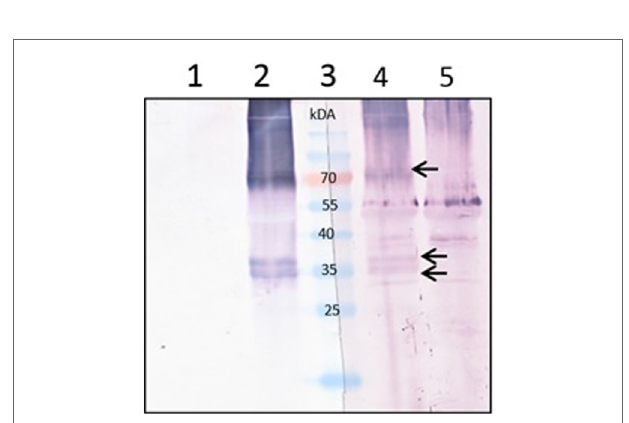
FigUre 3 | Quantification of Zera ® M2e produced in plants . Bovine serum albumin (BSA) was used as a standard. Lane 1 and 7 contained PageRuler ™ Prestained protein ladder (Fermentas), lane 2 contained 6.26 mg/ml, lane 3 contained 3.13 mg/ml, lane 4 contained 1.56 mg/ml, and lane 5 contained partially purified Zera ® M2e plant-codon optimized protein. While lane 6 is a western blot containing the partially purified Zera ® M2e plant-codon optimized protein detected with anti-Zera ® antibody.